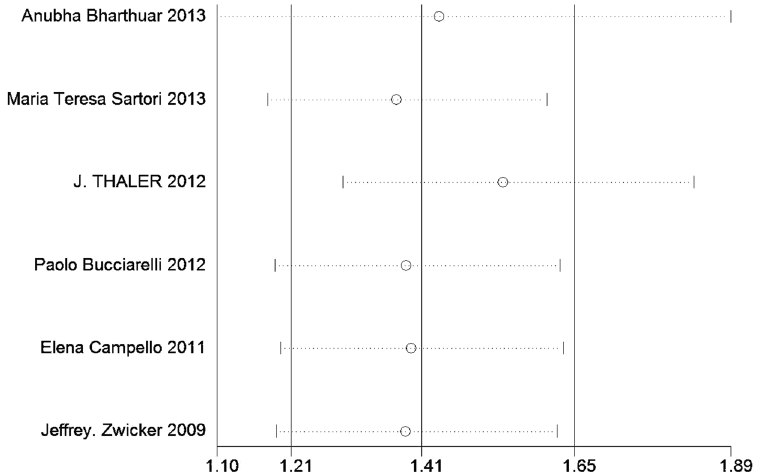
Figure 5. Sensitivity analysis by omitting one study each time, each small circle and dotted lines respectively represent the OR and corresponding 95% CI of the remaining studies after excluding the corresponding